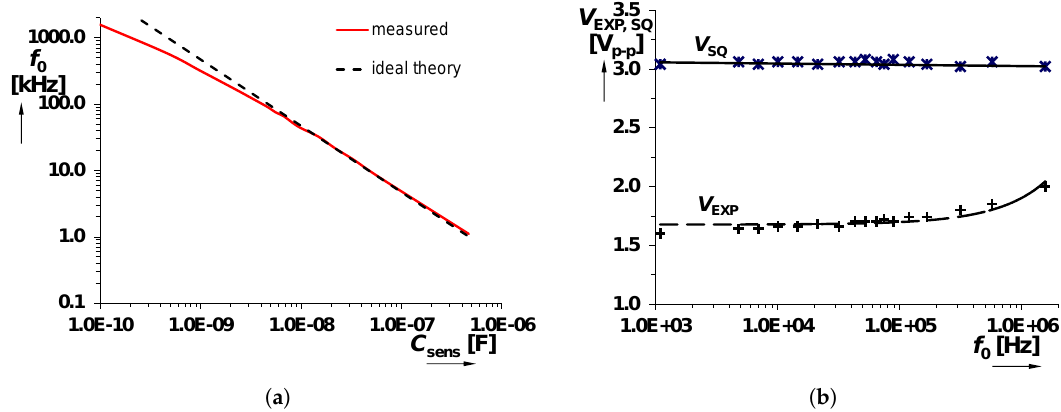
Figure 6. Features of the proposed generator: ( a ) f 0 versus C sens ; ( b ) output levels versus f 0 .